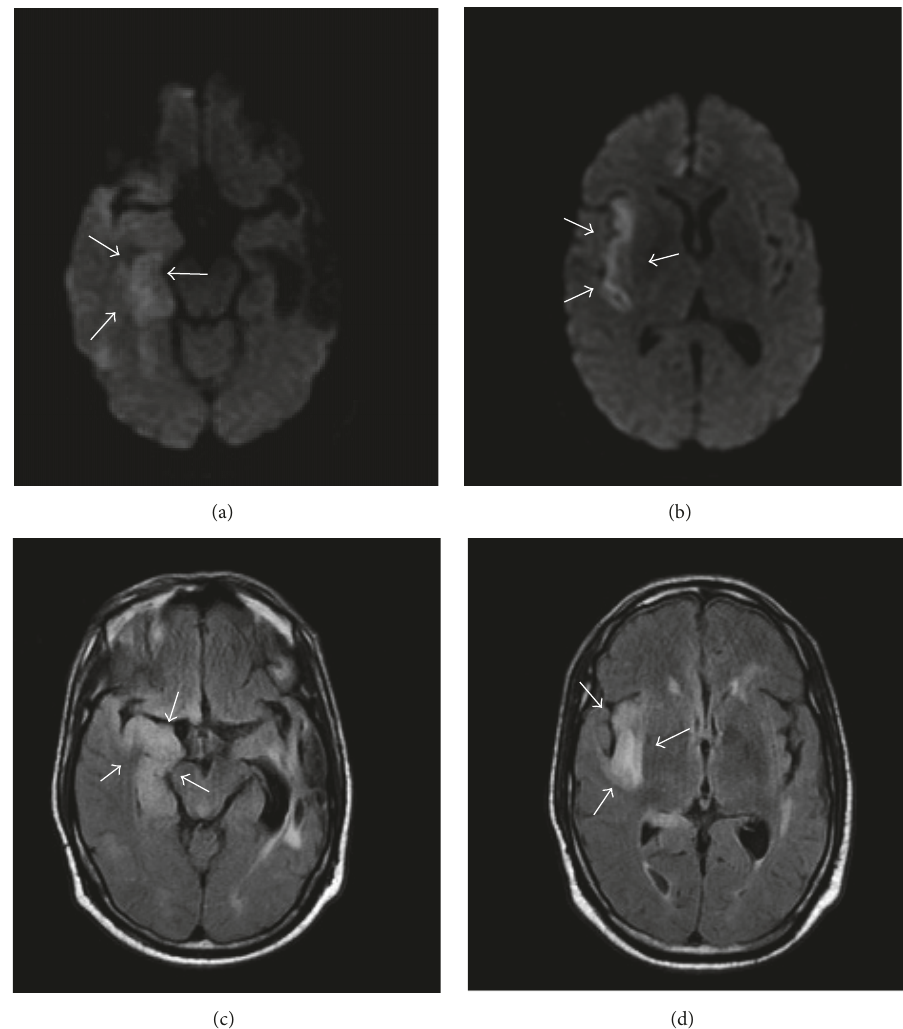
Figure 2: (Day 2) ((a) and (b)) noncontrast MRI of the brain: Diffusion Weighted Imaging (DWI) demonstrates increased signal in the right temporal lobe (a) and right insula (b), consistent with cytotoxic edema. Restricted diffusion is less intense as compared to infarction. These imaging findings in combination with clinical scenario are highly suggestive of herpes simplex encephalitis. ((c) and (d)) Noncontrast MRI of the brain: FLAIR sequence demonstrates asymmetrical involvement of the right medial temporal lobe (c) and the insular cortex (d). Unlike in middle cerebral territory infarct, basal ganglia is spared. Arrows in (a) refer to increased signal in right temporal lobe, in (b) increased signal in right insula, in (c) FLAIR sequence demonstrating involvement of right medial temporal lobe, and in (d) FLAIR sequence demonstrating involvement of right insular